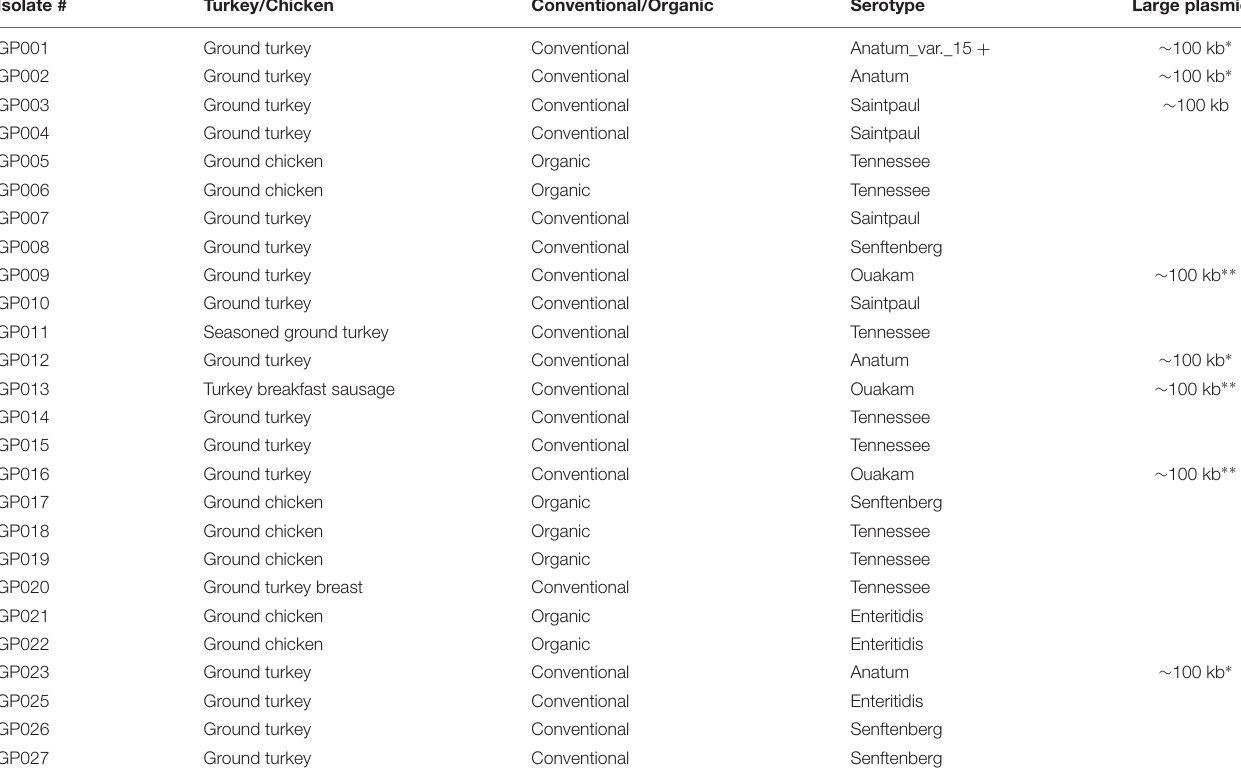
TABLE 2 | Ground poultry sources, serotypes and large plasmid profiles of the 26 Salmonella isolates characterized in this study. Isolate # Conventional/Organic